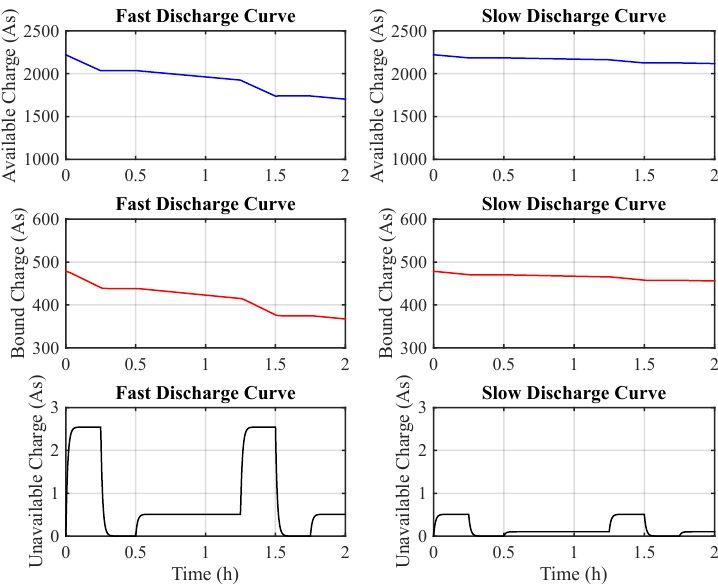
Figure 3. An example of KiBaM behavior over